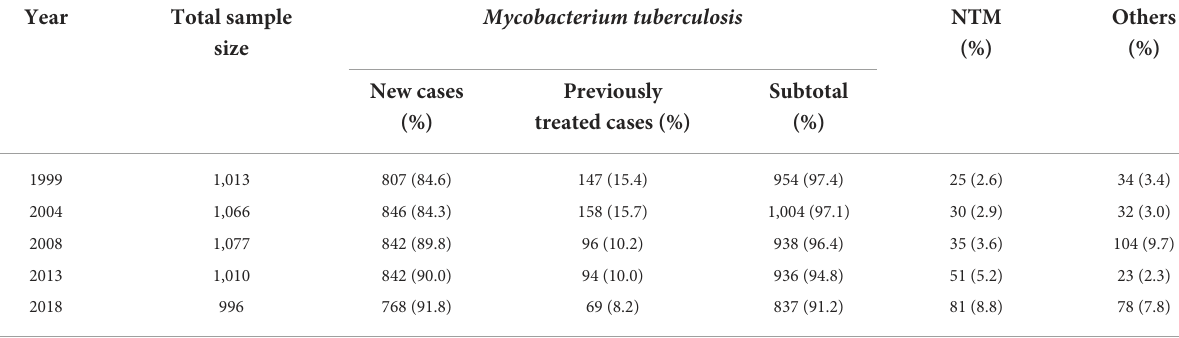
TABLE 1 TB case distribution by five surveys in Zhejiang Province, 1999–2008.